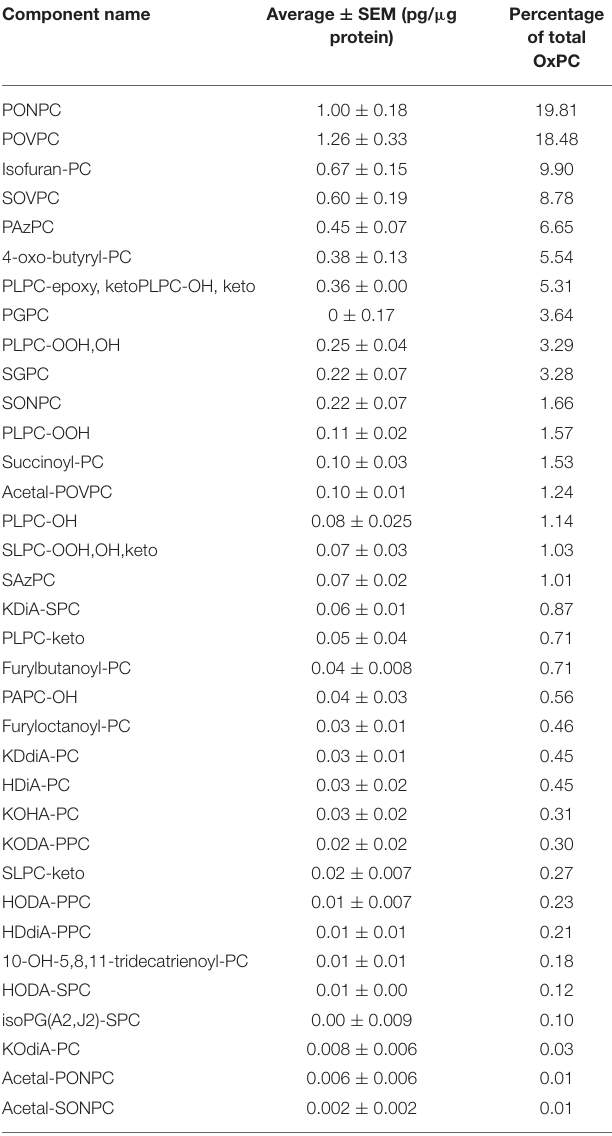
TABLE 4 | Quantified OxPCs in thrombus of STEMI